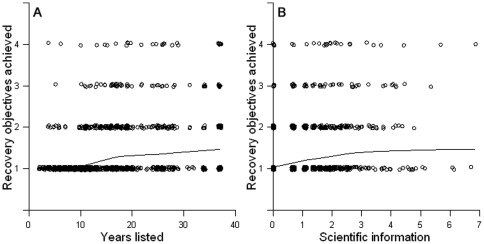
Recovery objectives achieved as a function of years listed and scientific information.Scatter plots of recovery objectives achieved and (a) number of years listed and (b) amount of peer-reviewed scientific information. Peer-reviewed scientific information is calculated as the number of Web of Science search conducted in July of 2007 of each species' scientific name and is natural logarithm transformed. Lines on the graphs show LOWESS smoothing functions with tension = 0.7. N = 1169.